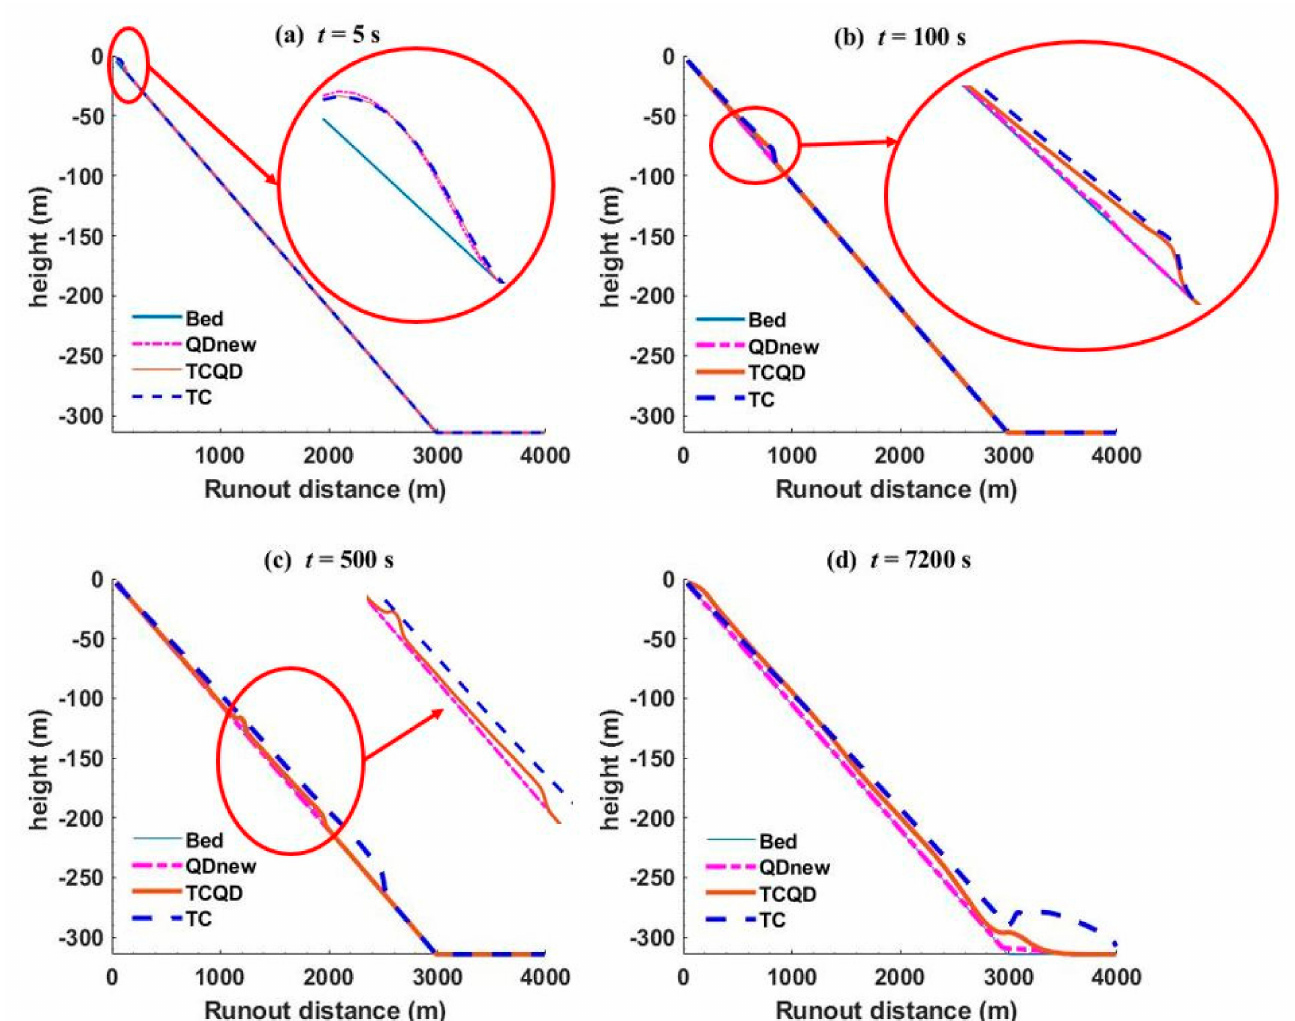
Figure 6. Debris heights along the slope for QDnew, TC, and TCQD at different times. ( a – d ) show the debris flow heights at 5 s, 100 s, 500 s, and 7200 s,